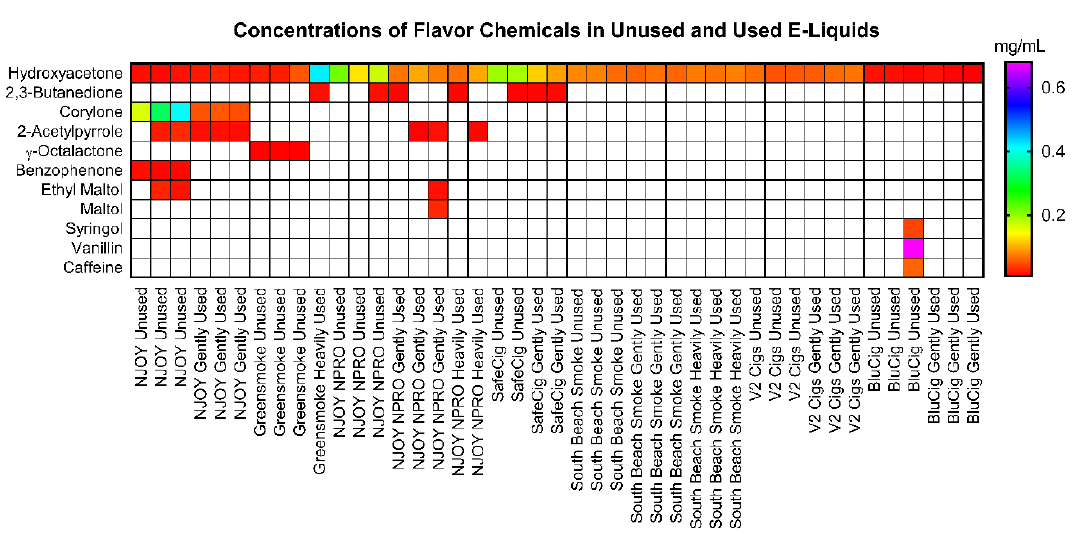
Figure 3. Heat map showing the concentration of flavor chemicals in aged unused and used e-liquids. Flavor chemicals are presented on the y axis, and EC products and sample types are on the x axis. All concentrations are in mg/mL White boxes indicate the flavor chemical was not detected.